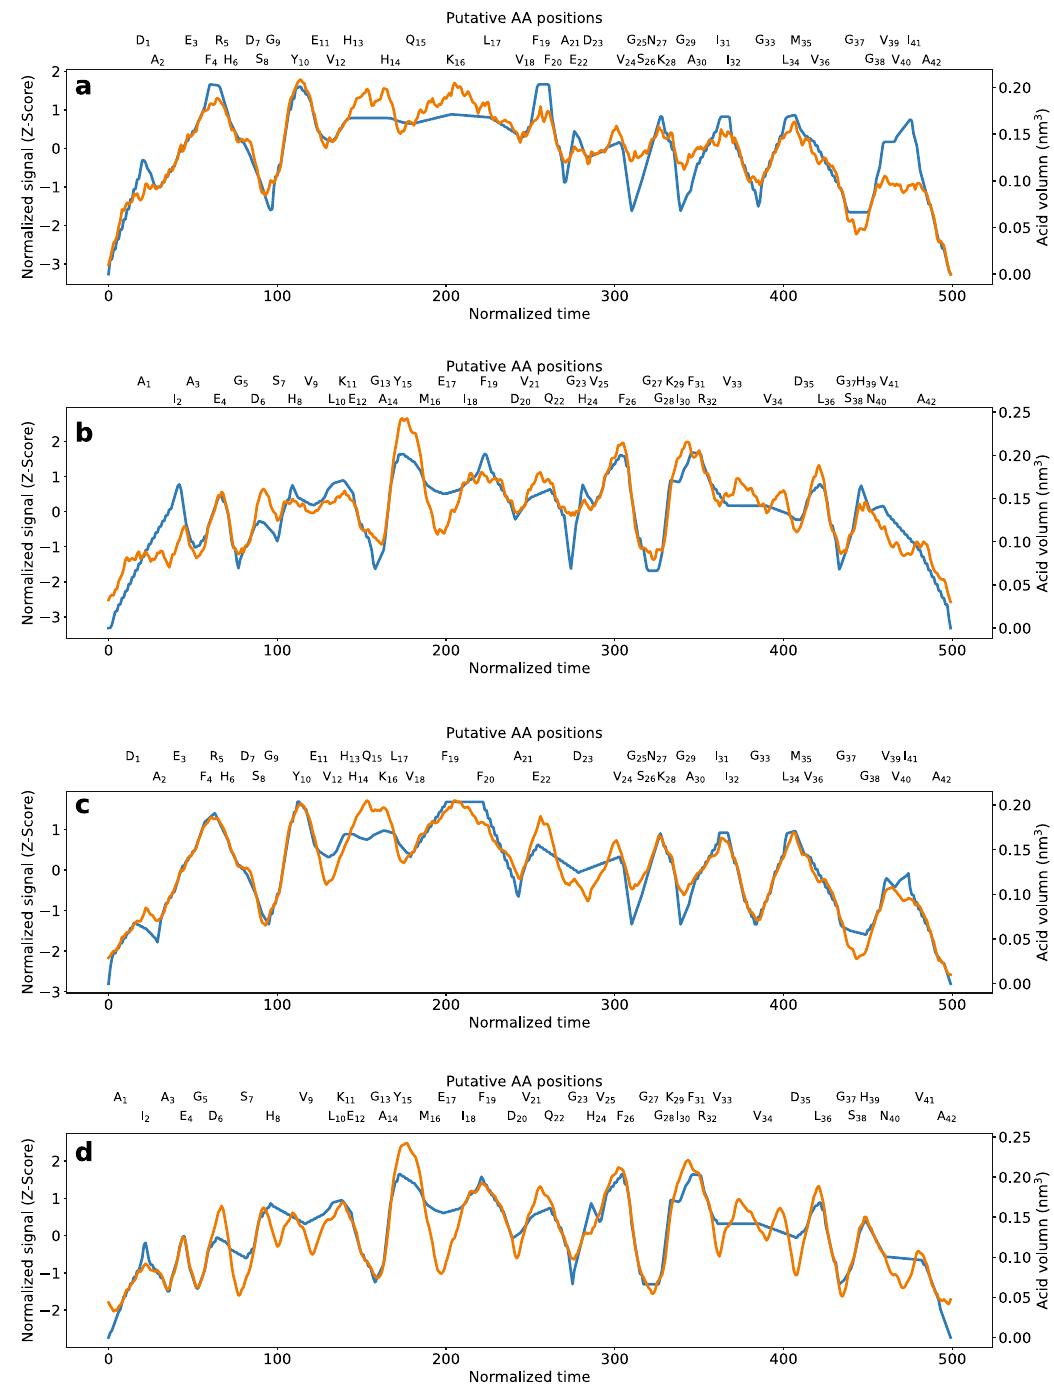
Figure 3. ( a ) A plot of a 475-blockade average consensus nanospectrum acquired at 0.6 V by forcing denatured Aβ 1–42 through a sub-nanopore is shown versus normalized duration (orange line). Aligned with the empirical data is the corresponding 1AAV model (blue line) using DTW. The blockade current is correlated (PCC = 0.896) with the corresponding volume model. ( b ) A plot of a 2000-blockade average consensus nanospectrum acquired at 0.6 V by forcing denatured SAβ 1–42 through a sub-nanopore is shown versus normalized duration (orange line). Aligned with the empirical data is the corresponding 1AAV mode (blue line) with DTW. The empirical consensus is correlated (PCC = 0.880) with the corresponding 1AAV model. ( c ) The alignment consensus nanospectrum (orange line) of Aβ 1–42 is aligned with the 1AAV-P model (blue line) with PCC = 0.954. ( d ) The alignment consensus nanospectrum (orange line) of SAβ 1–42 is aligned with the 1AAV-P model (blue line) with PCC =